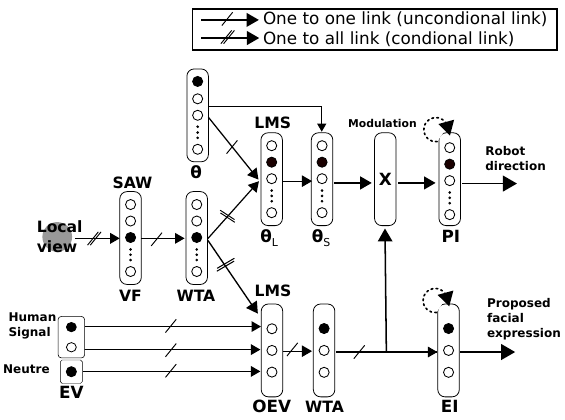
Figure 5: Berenson global sensory-motor architecture.